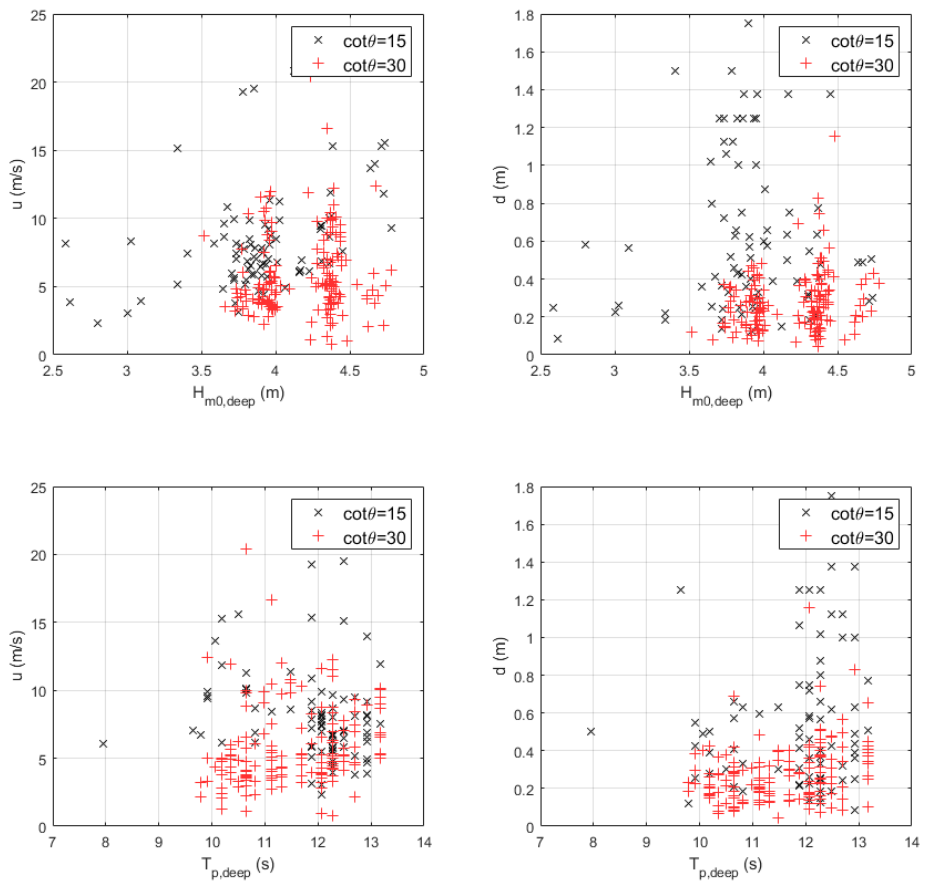
Figure 13. Variation of overtopping layer velocity and depth with deep-water wave characteristics (dimensions in prototype) for two different foreshore slopes.